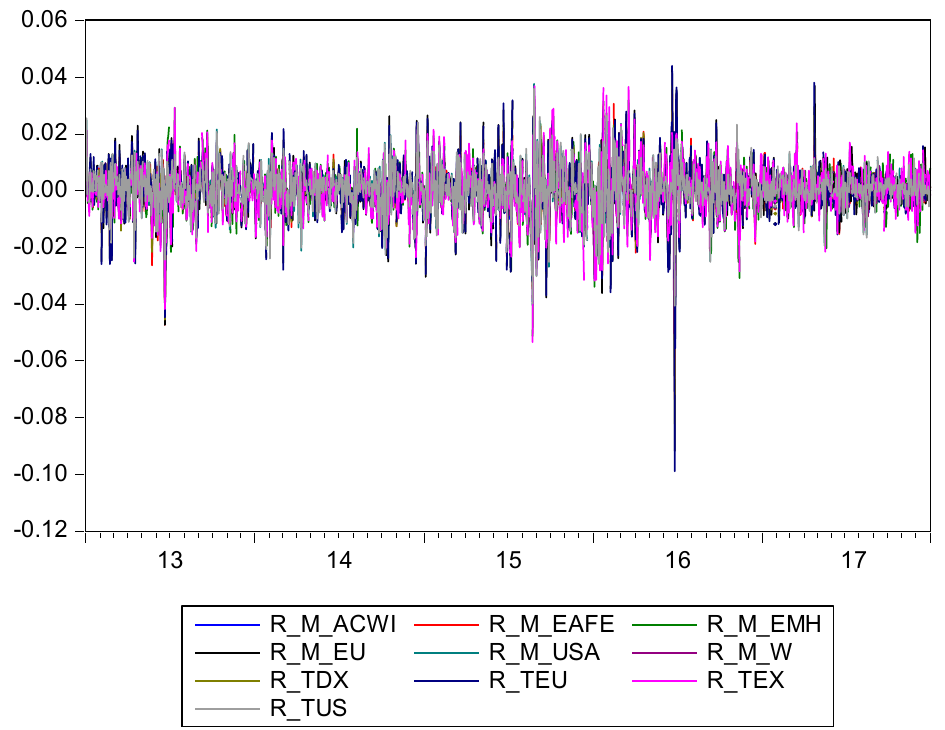
Figure 2. Consolidated graph of the ten indices.